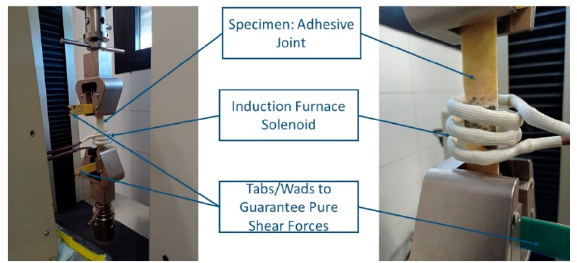
Figure 1. Experimental setup of single-lap shear test, where the adhesive joint is heated by induc-